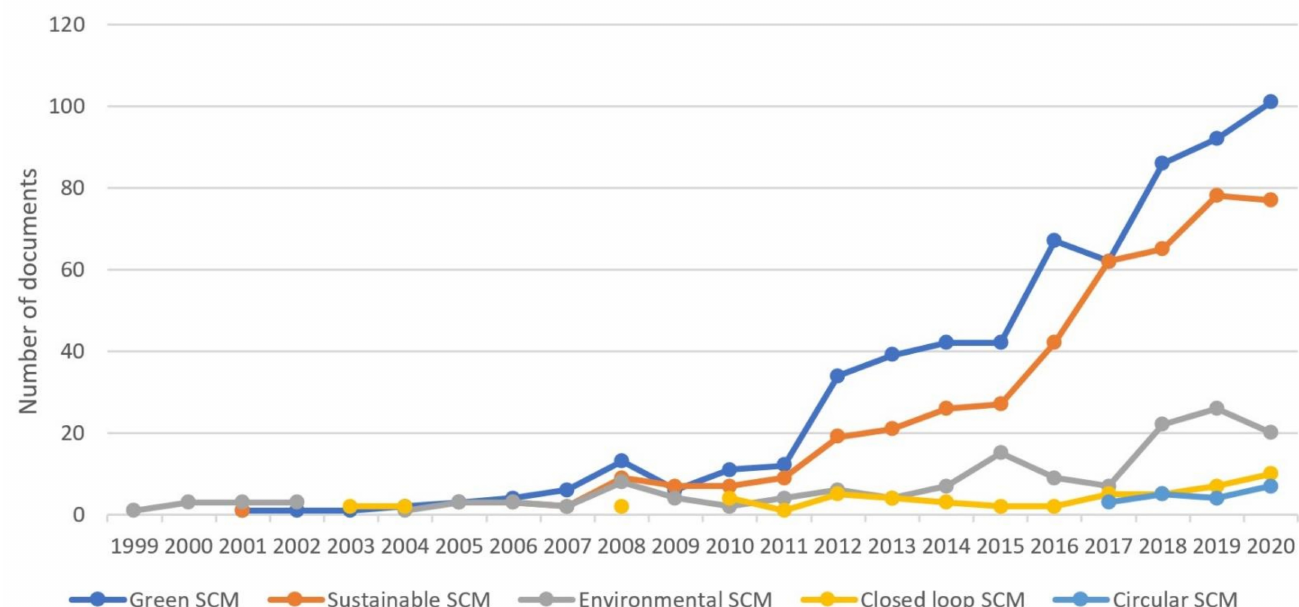
Figure 6. Publication trends on subareas of